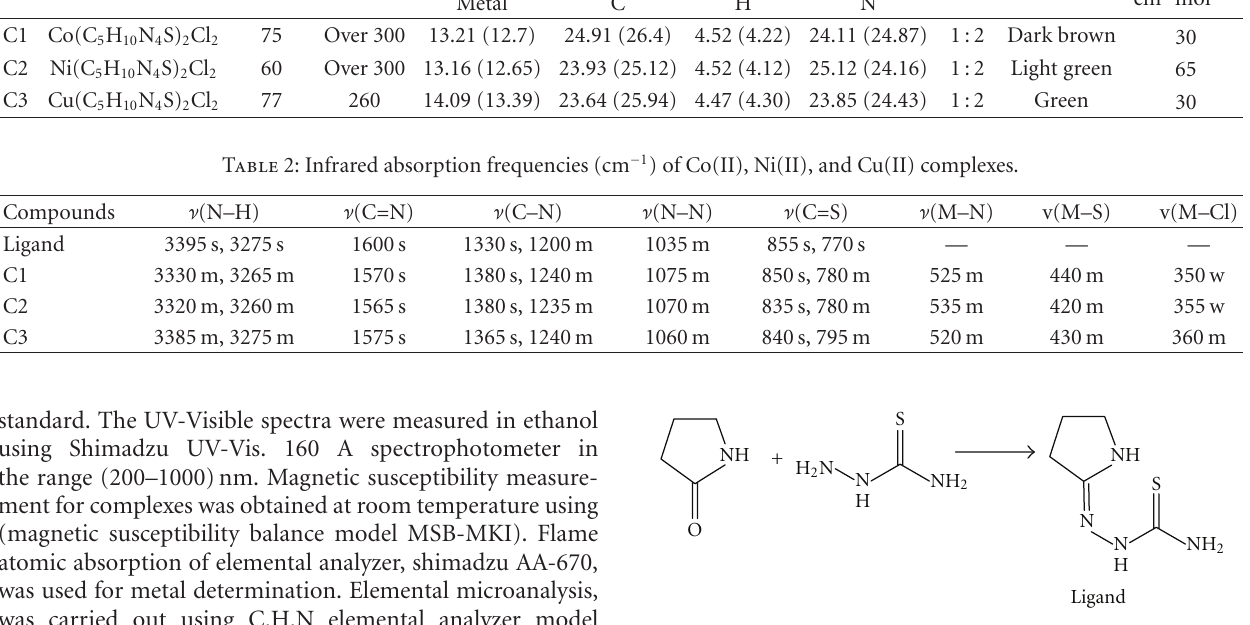
Table 1: Conductivity, colors, and elemental analysis data of the complexes. NO. Complex Yield % M.P. ◦ C